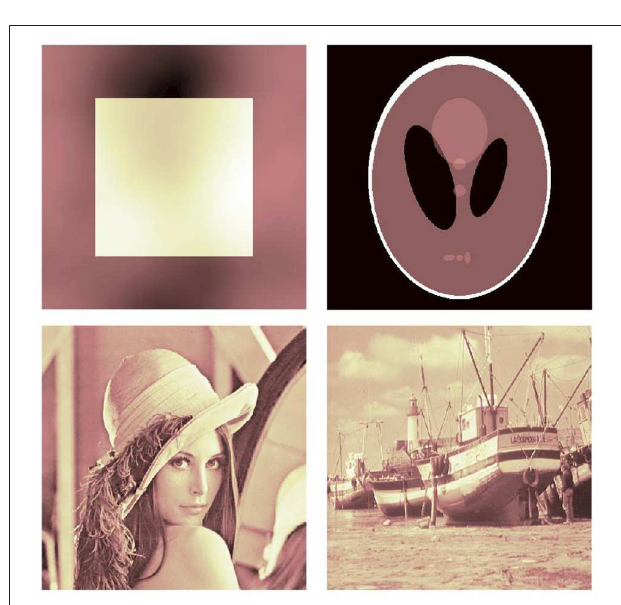
FIGURE 1 | Illustration of domains.